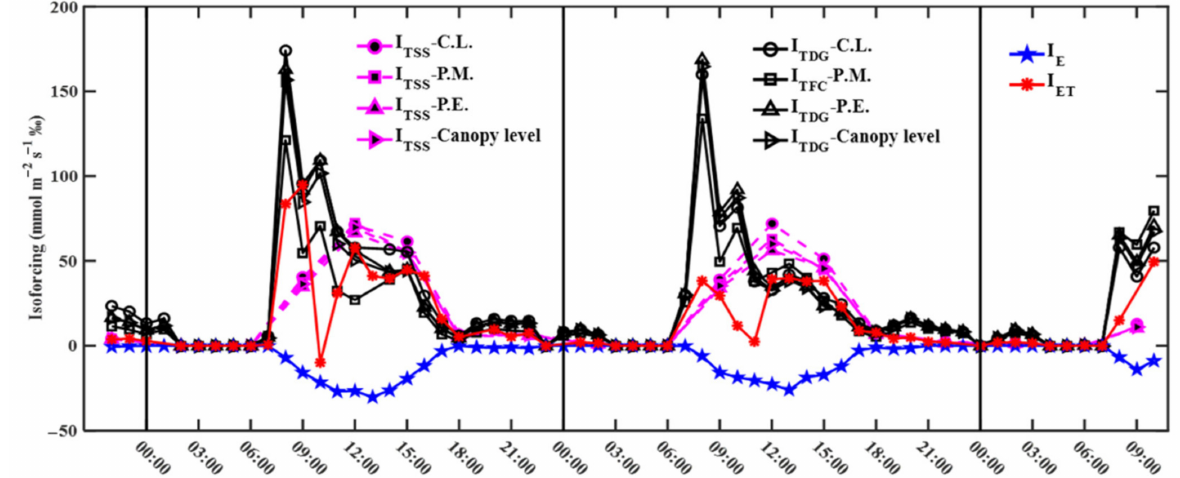
Figure 7. Diurnal patterns of transpiration isoforcing via non-steady (I TDG and I TFC ) and steady- state (I TSS ), evaporation isoforcing (I E ), and evapotranspiration isoforcing (I ET ). I TDG and I TFC were calculated by δ 18 O T which were obtained by using simulated δ 18 O L,e with the Dongmann (DG) and Farquhar–Cernusak (FC) model into Equation (10), respectively. C.L., P.M., and P.E.